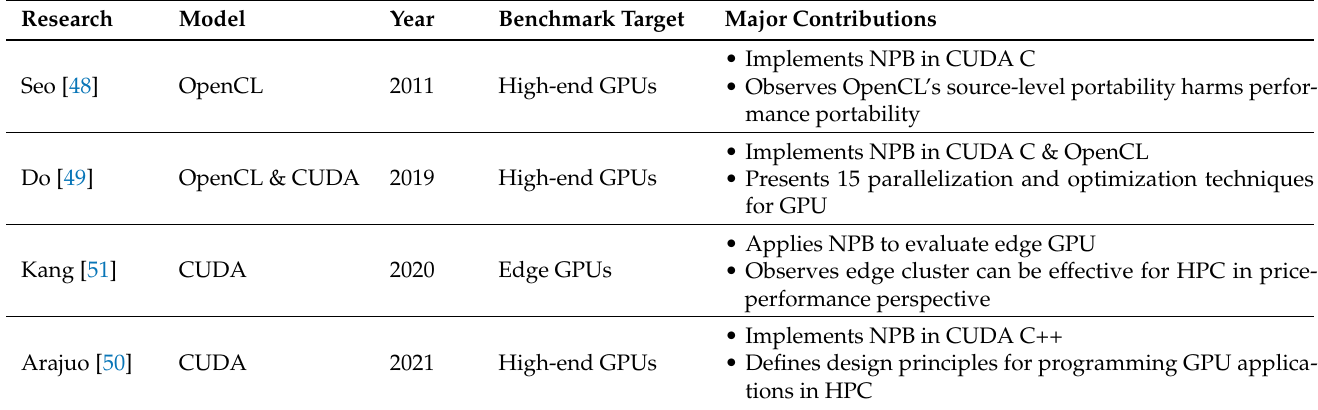
Table 2. Summary of NPB Benchmark Research for HPC on